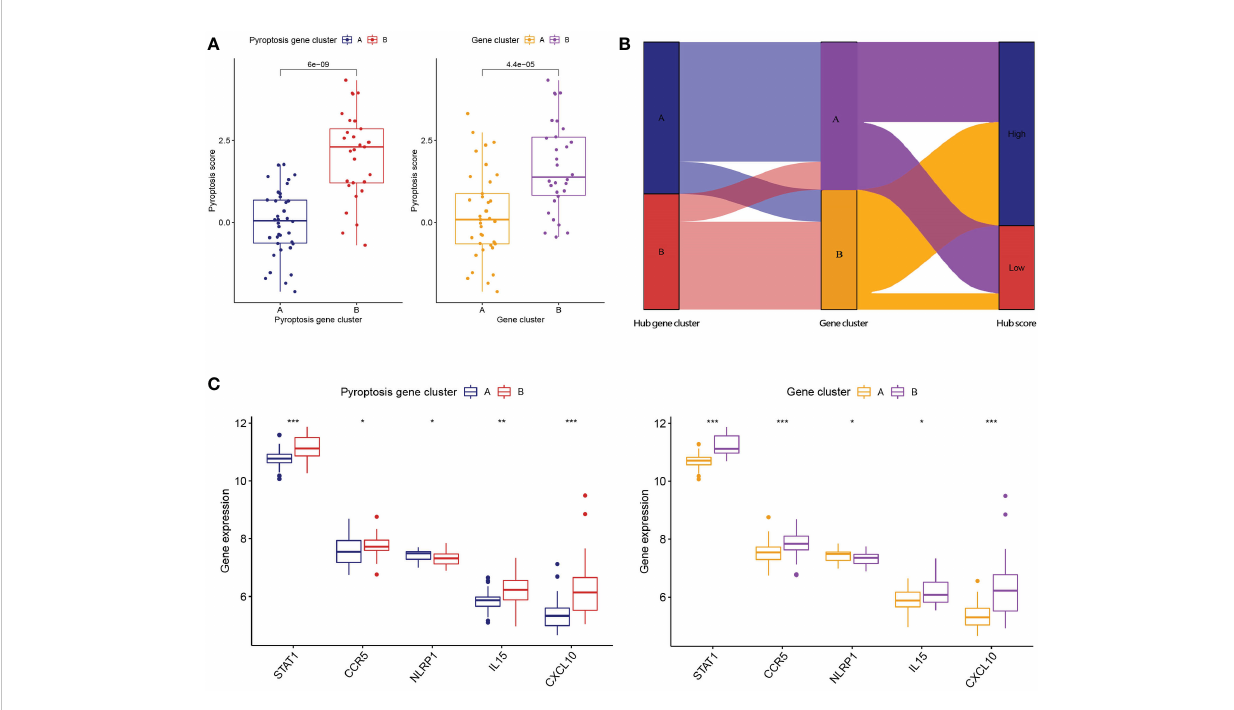
FIGURE 6 Role of pyroptosis patterns in distinguishing RA. (A) Differences in pyroptosis score between pyroptosis gene cluster A and B and differences in pyroptosis score between gene cluster A and B. (B) Sankey diagram showing the relationship between pyroptosis patterns, pyroptosis gene patterns, and pyroptosis scores. (C) Differential expression levels of STAT1, CCR5, NLRP1, IL-15, and CXCL10 between pyroptosis gene cluster A and B. (C) Differential expression levels of STAT1, CCR5, NLRP1, IL-15, and CXCL10 between gene cluster A and B. * means P < 0.05, ** means P < 0.01, *** means P <